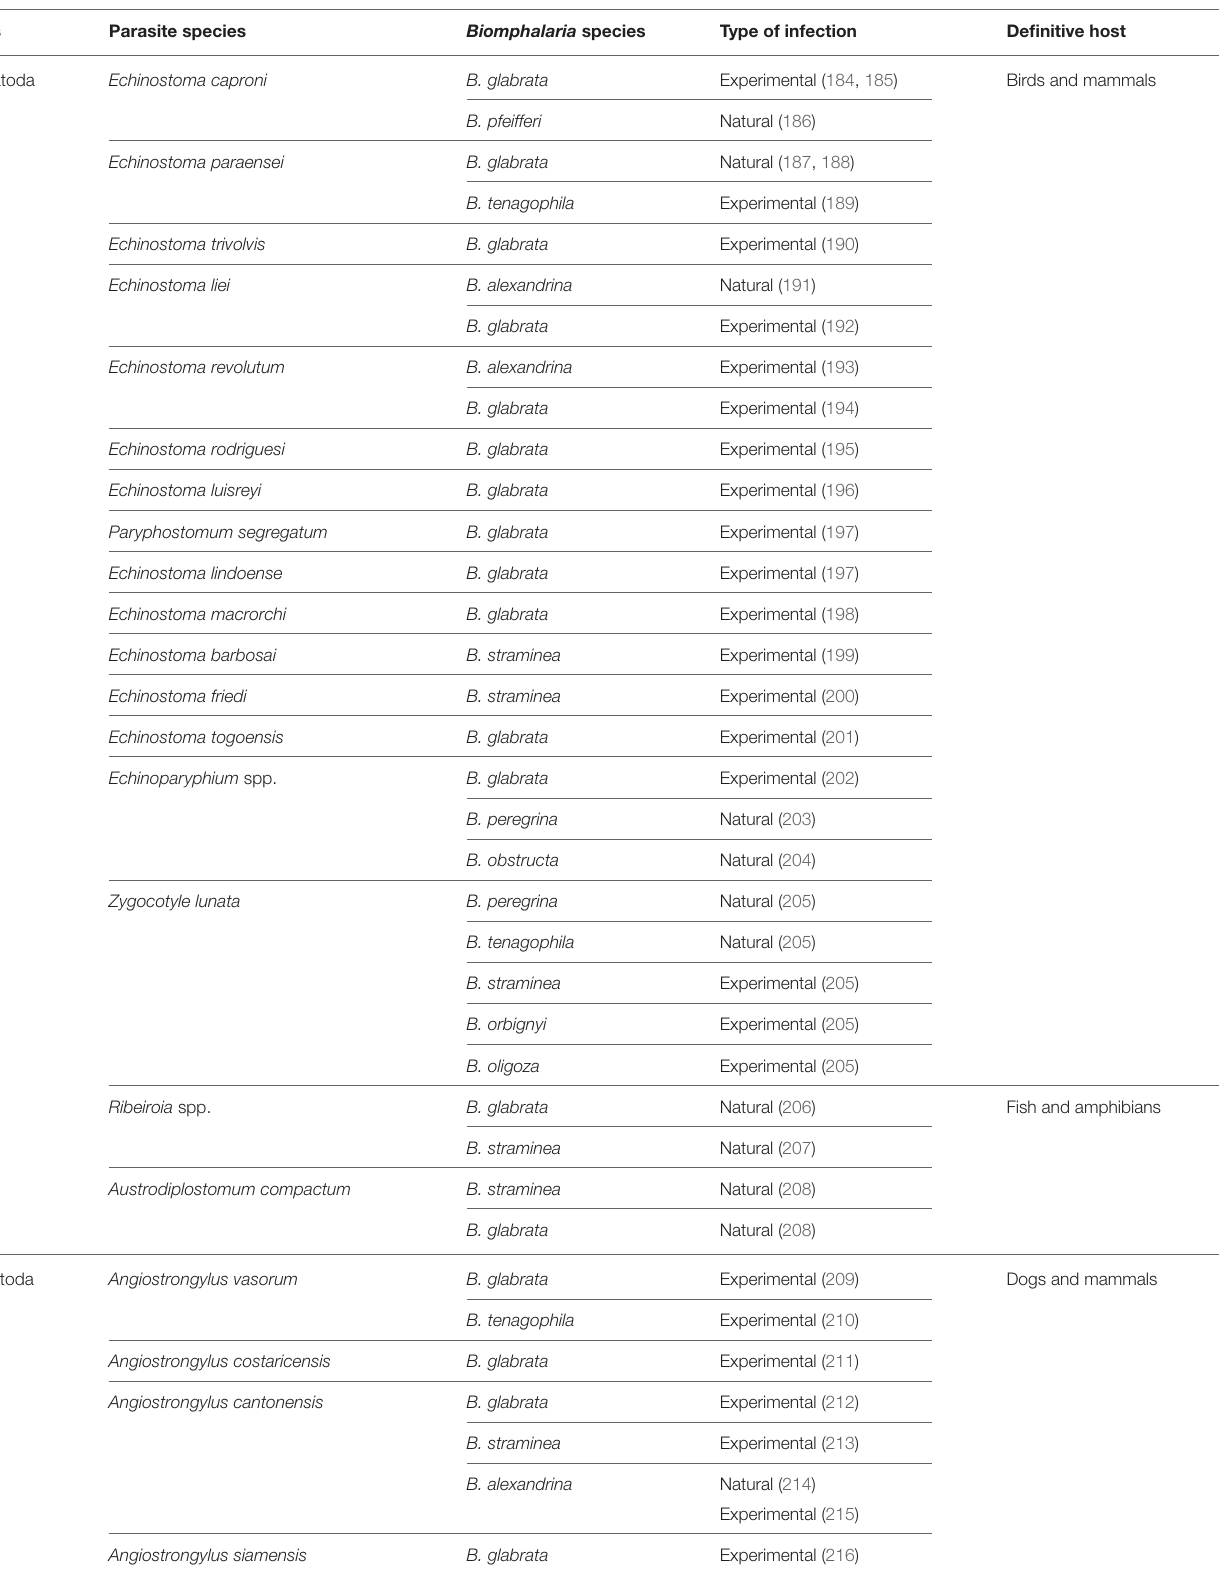
TABLE 2 | Trematodes and nematodes parasites using Biomphalaria as intermediate